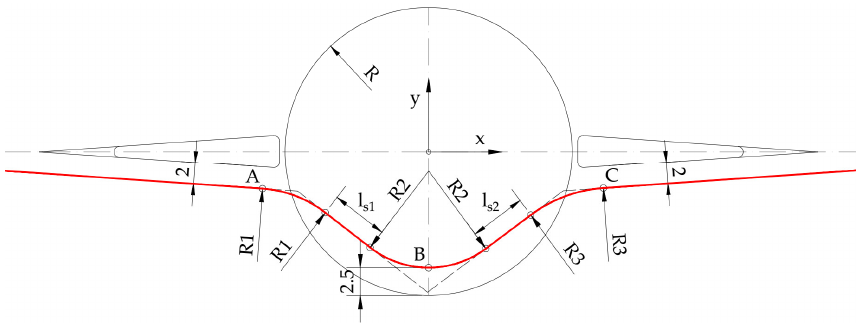
Figure 2. The A-1 FACPP construction approach.